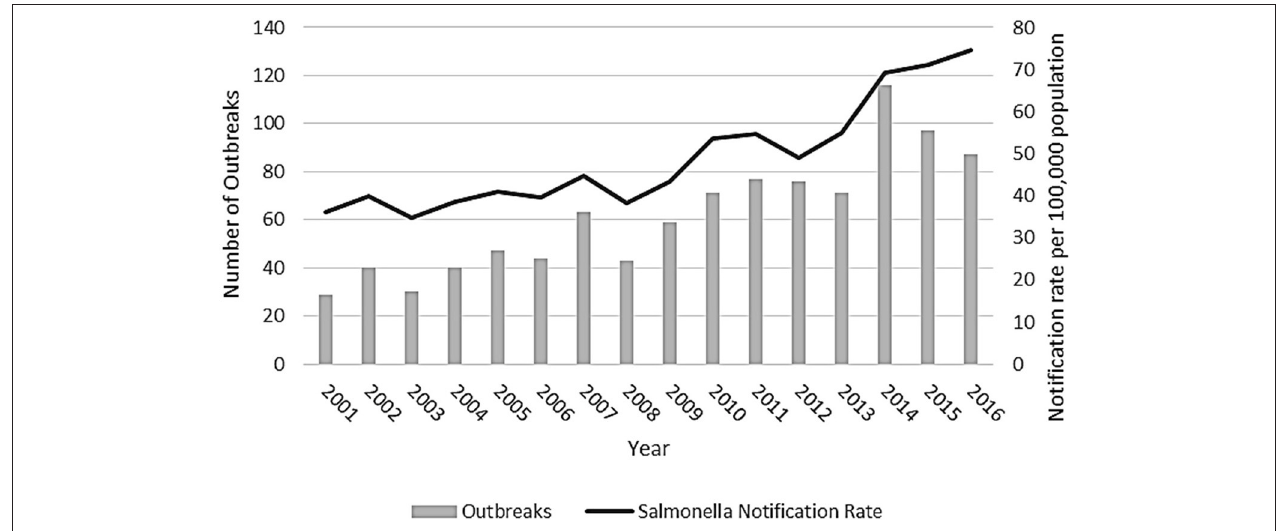
FIGURE 1 | Salmonellosis outbreaks reported in the OzFoodNet outbreak register and National Notifiable Disease Surveillance System Salmonella notification rate, Australia,